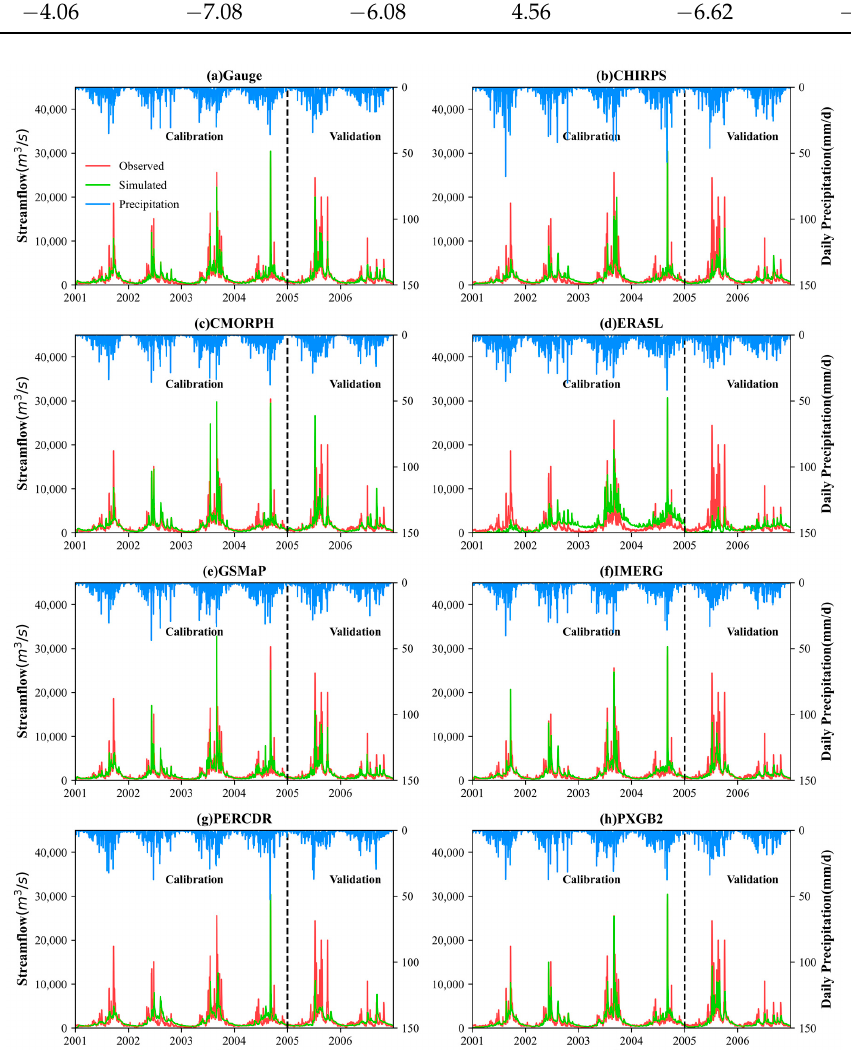
Figure 8. Comparison of observed and BTOP simulated daily streamflow using gauge observations and seven MSPs in calibration and validation periods under scenario II.